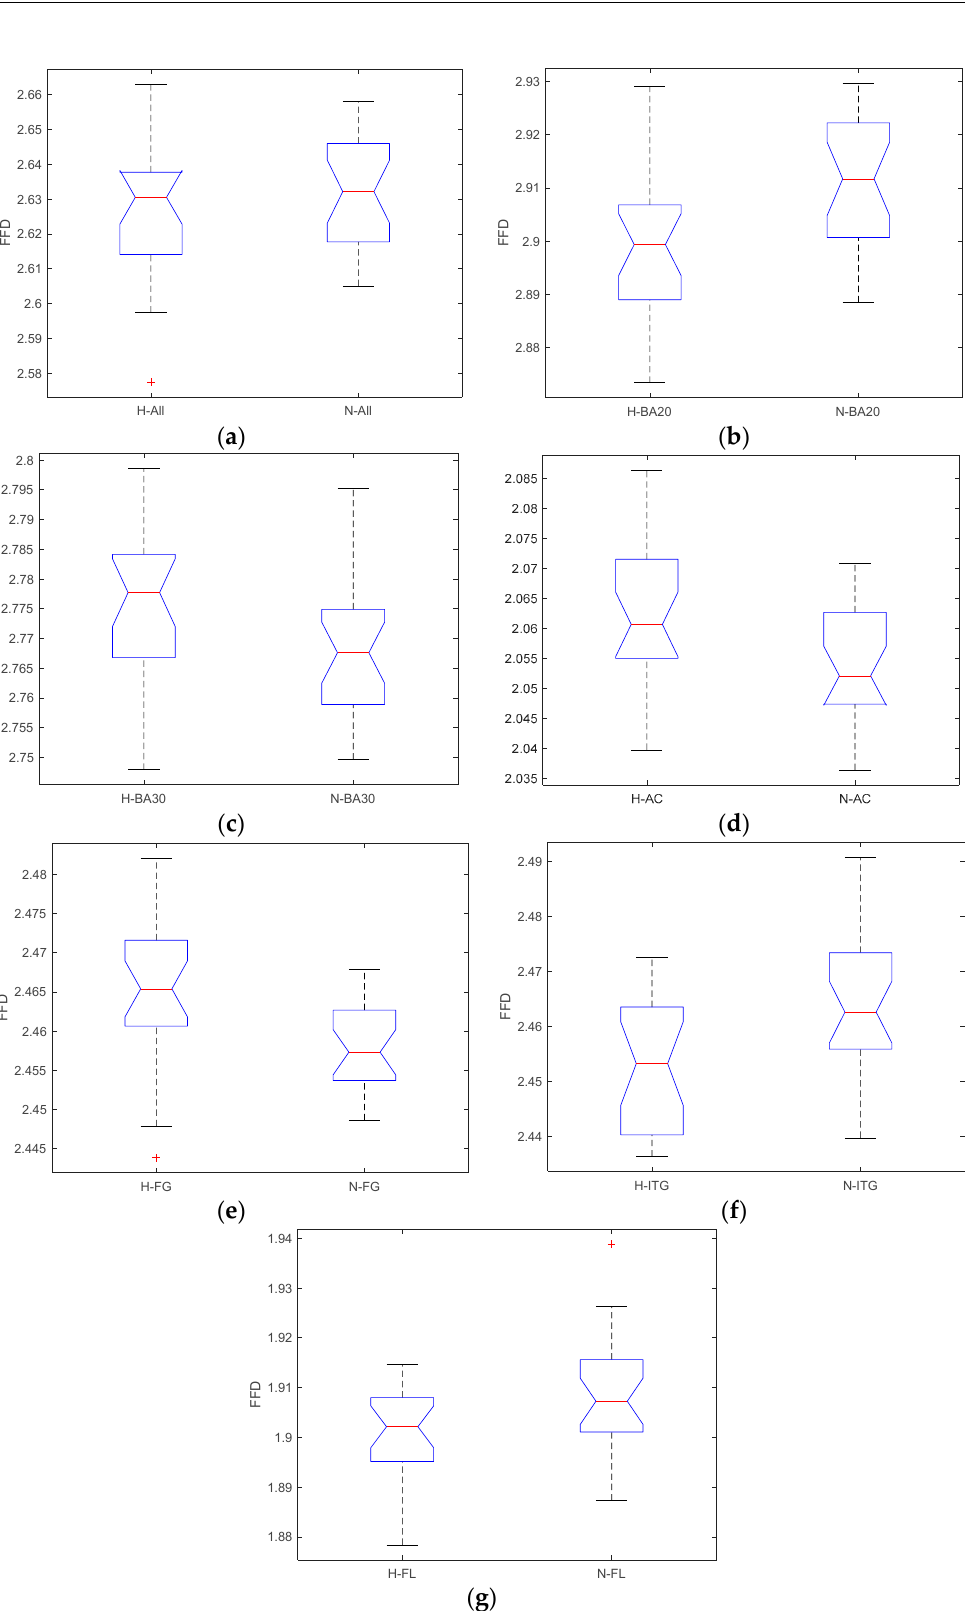
Figure 6. FFD values for huffaz and non-huffaz measured in the following VOI: ( a ) whole brain structure, ( b ) Brodmann area 20, ( c ) Brodmann area 30, ( d ) anterior cingulate, ( e ) fusiform gyrus, ( f ) inferior temporal gyrus, and ( g ) frontal lobe. The plus signs (+) indicate